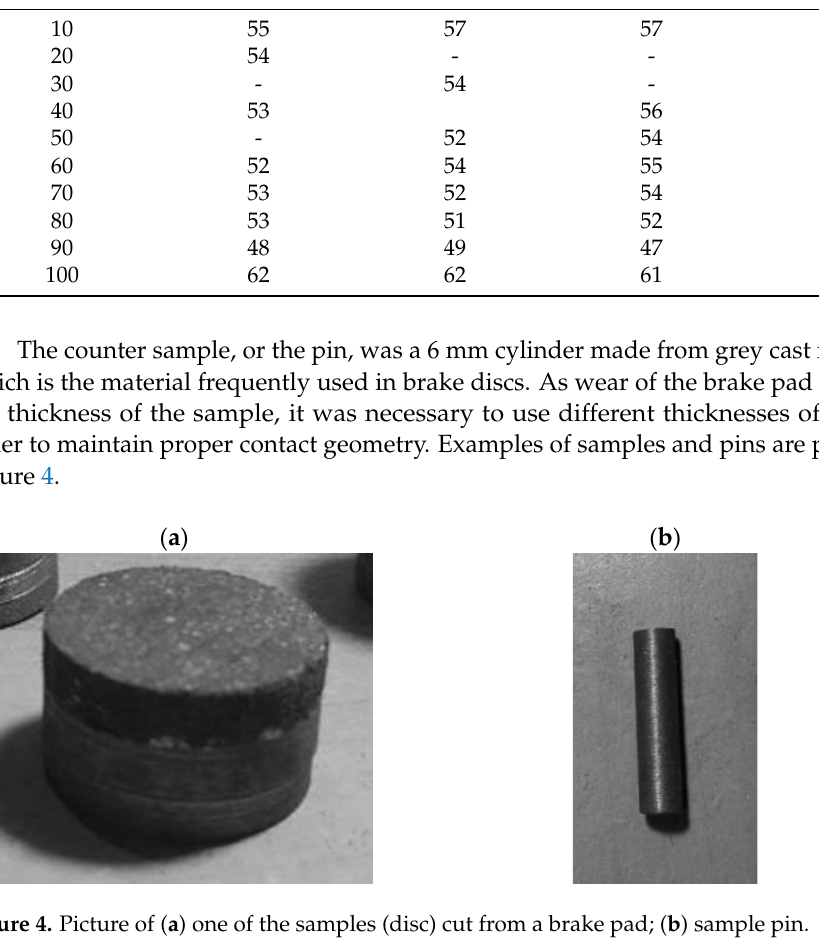
Figure 4. Picture of ( a ) one of the samples (disc) cut from a brake pad; ( b ) sample